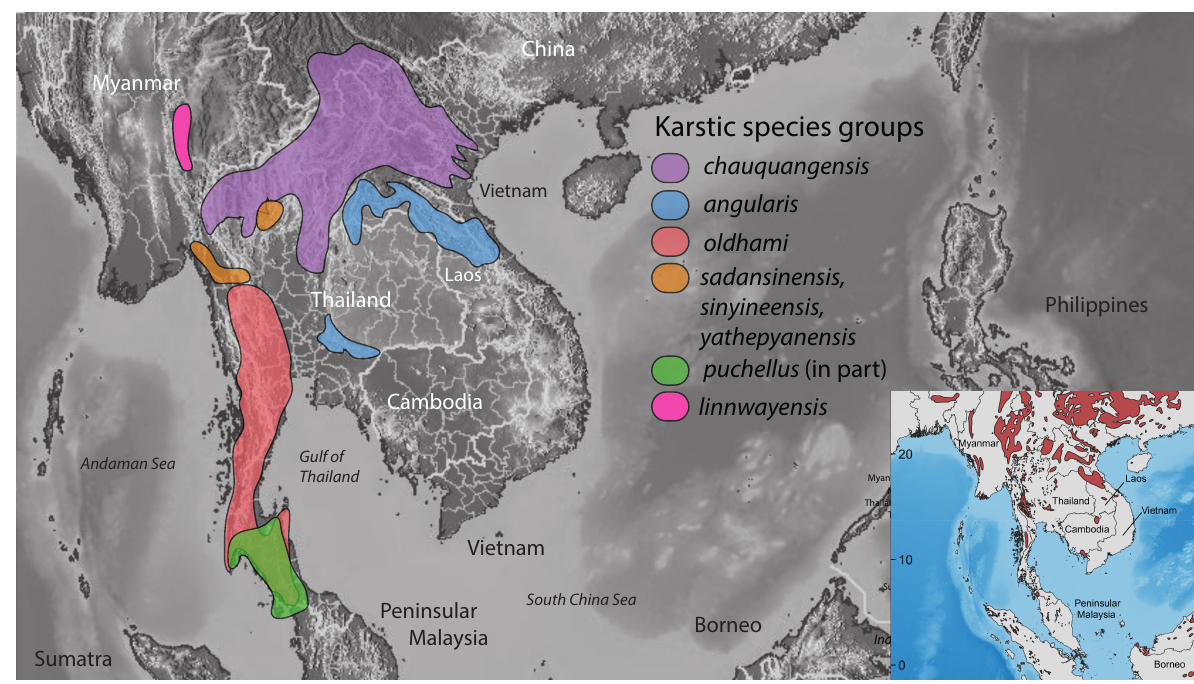
Figure 8. Distribution of the major clades of the karst-associated species groups throughout Indochina. Inset illustrates their co-distributions, with the geographic areas bearing the most extensive karstic